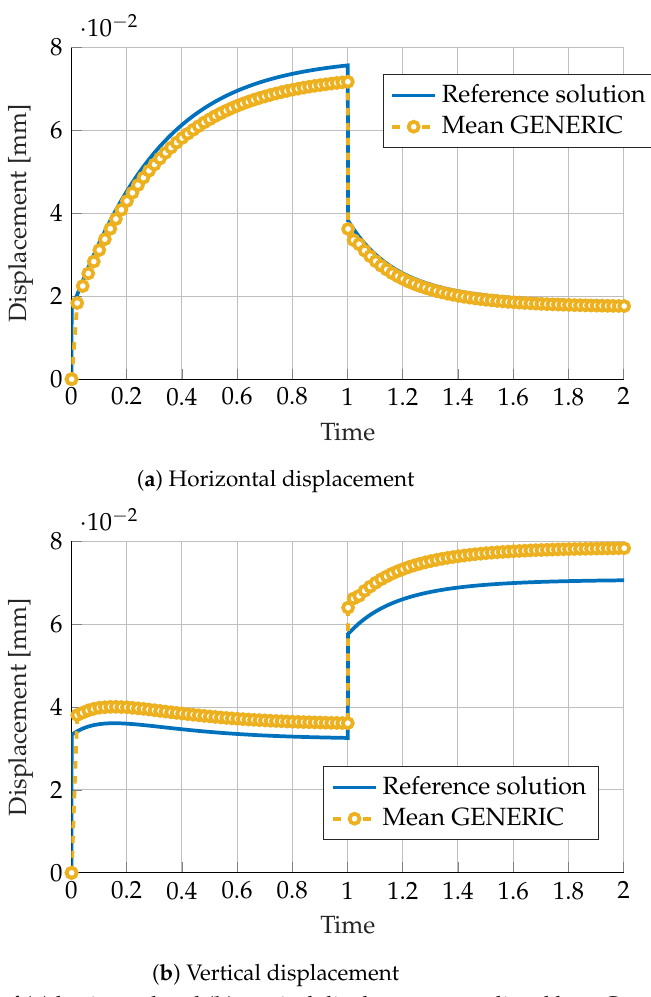
Figure 5. Comparison of ( a ) horizontal and ( b ) vertical displacement predicted by a General Equation for the Nonequilibrium Reversible-Irreversible Coupling (GENERIC) model obtained as the mean of 50 different noisy GENERIC models. Comparison with the noise-free reference solution in continuous blue line.